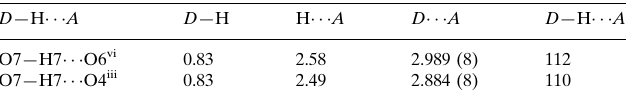
Hydrogen-bond geometry (A˚ , (cid:3)